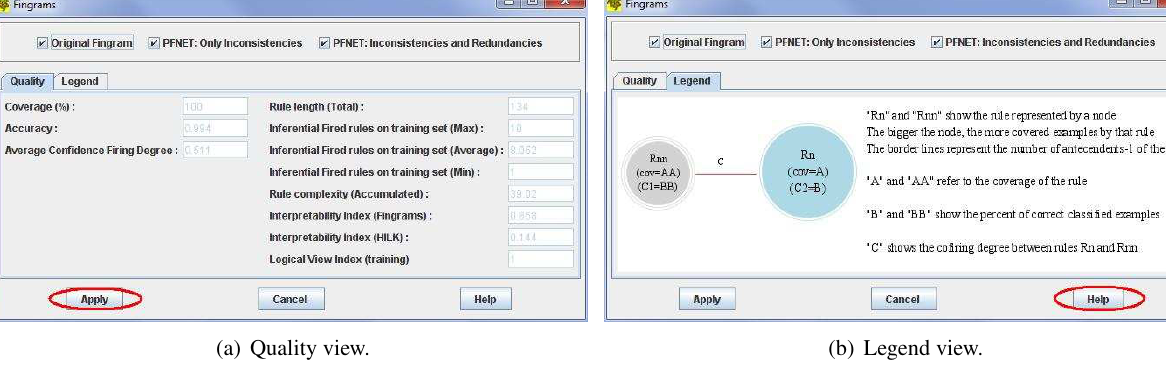
Figure 5: GUAJE fingrams